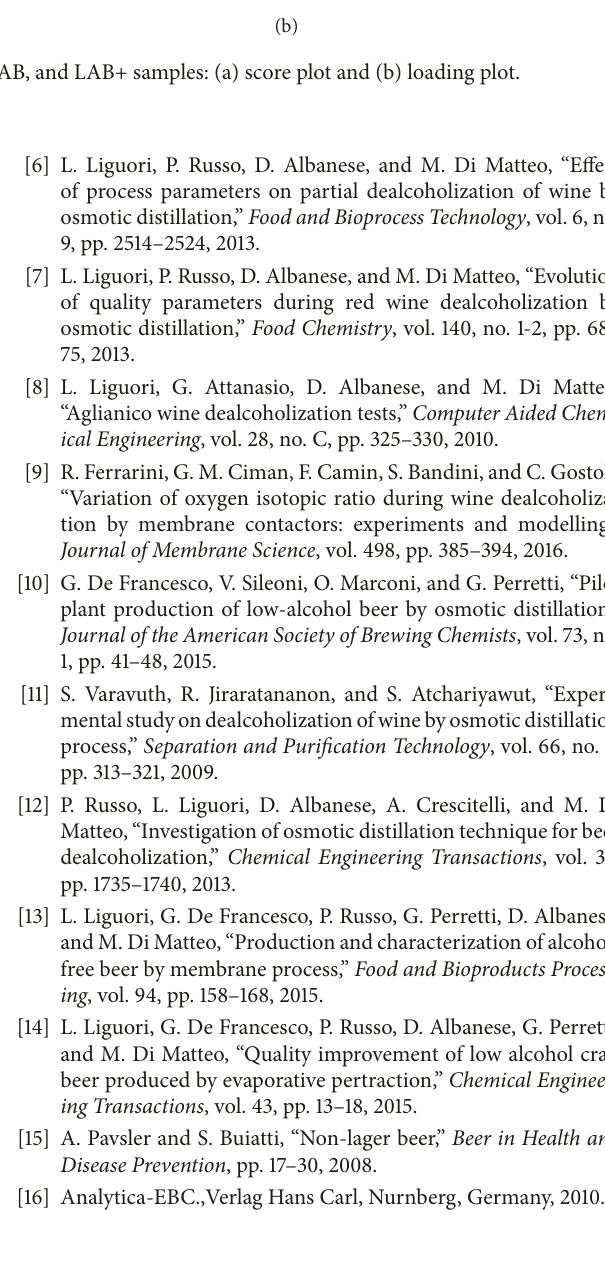
Figure 5: PCA plots of aroma sensory evaluation of OB, LAB, and LAB+ samples: (a) score plot and (b) loading plot.